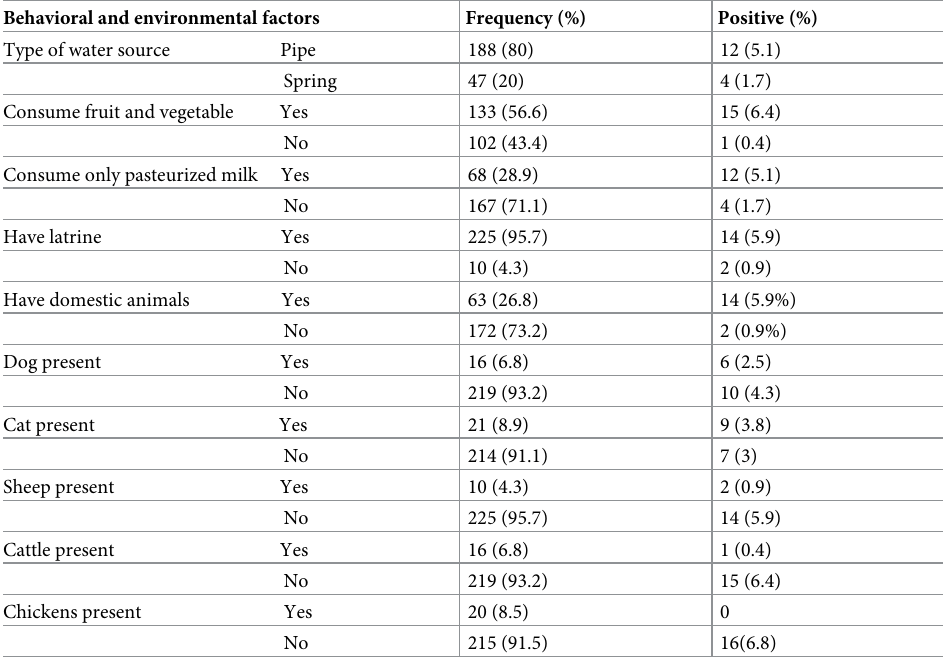
Table 2. Environmental health conditions and behavioral practices for Campylobacter infection among under- five children with diarrhea at governmental hospitals in Hawassa city, Sidama, Ethiopia, 2021. Behavioral and environmental